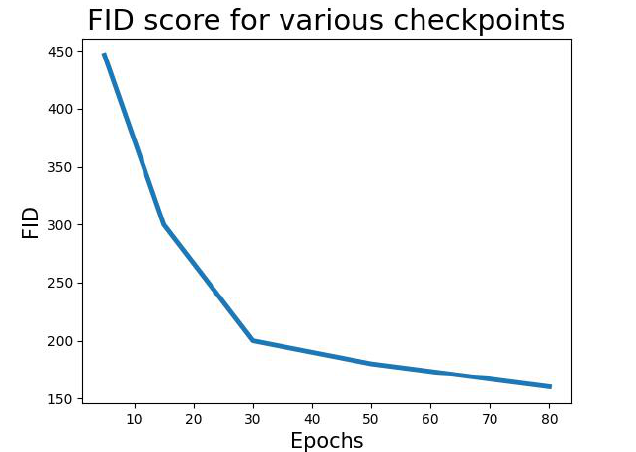
Figure 5. Frechet Inception Distance score for various epoch